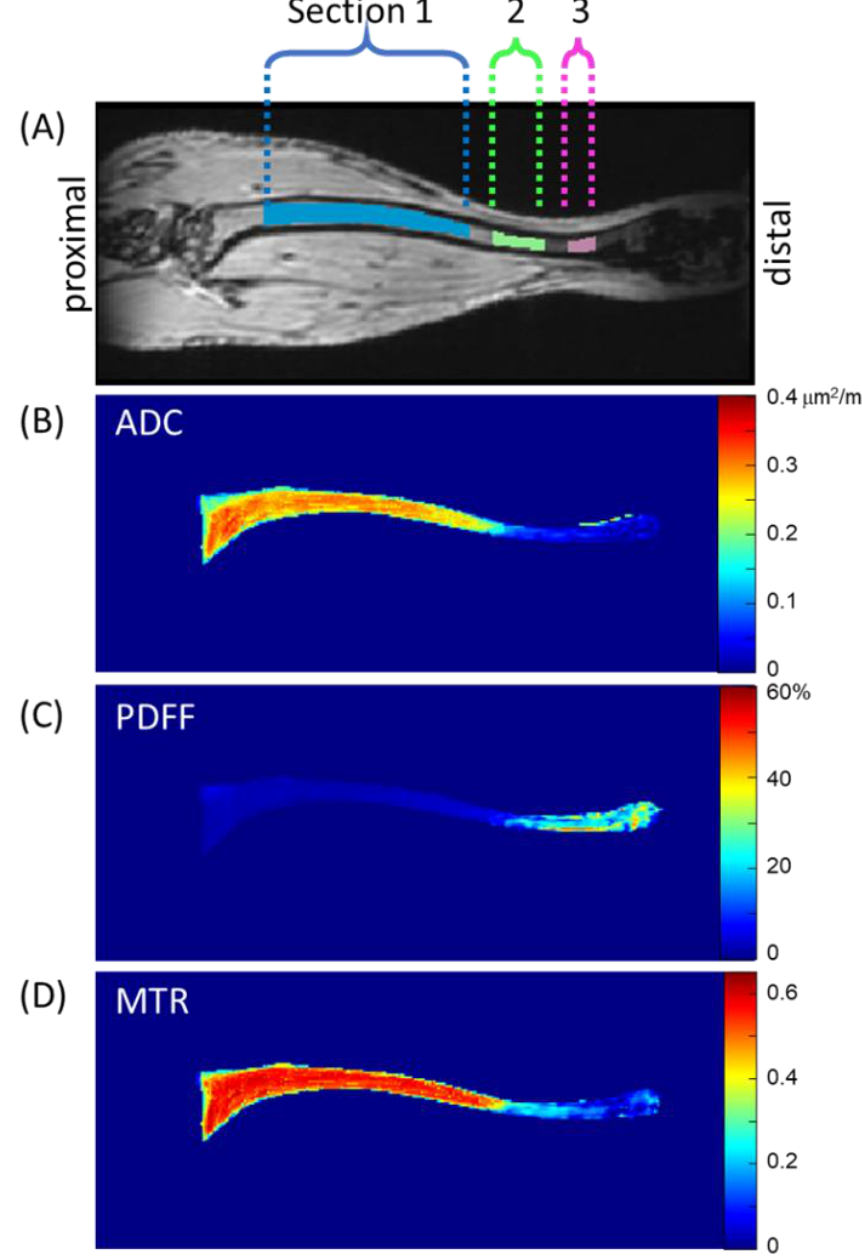
Figure 1. ( A ) Coronal slice through volumes of interest (VOI) along length of tibia shows Sections S1–S3. For the image shown, volumes in S1, S2, and S3 were 3.5, 0.3, and 0.2 mm 3 , respectively. Coronal projections of mean biomarker value within the tibia bone marrow are shown for biomarker maps ( B ) ADC in µm 2 /ms units, ( C ) PDFF in %, and ( D ) MTR (dimensionless).